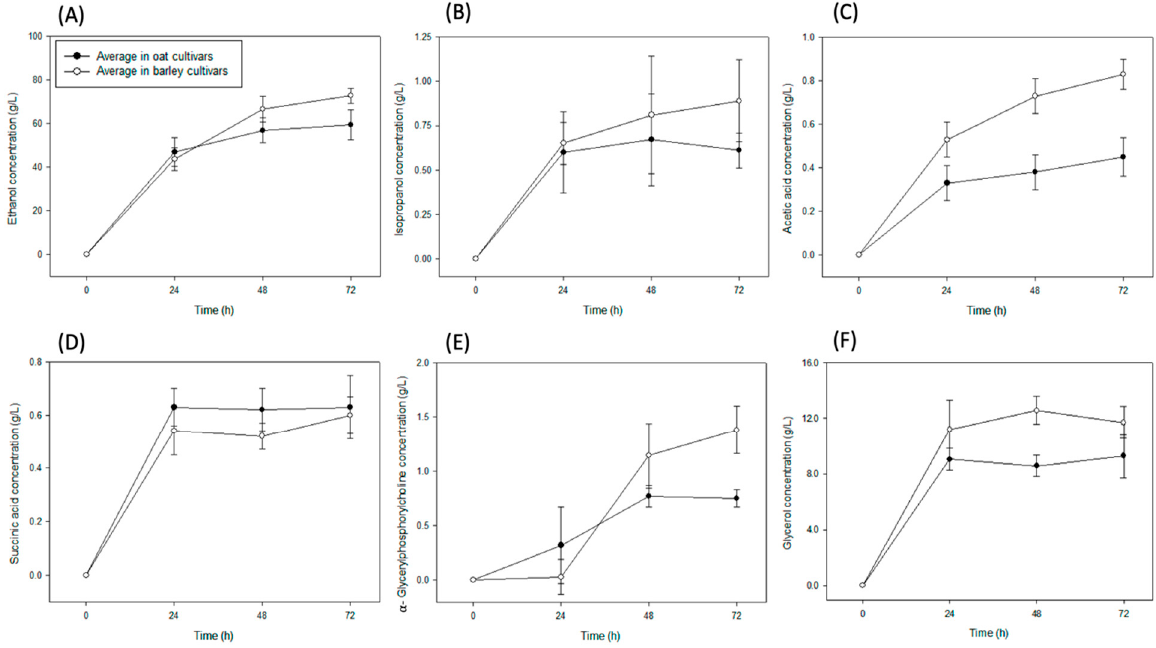
Figure 3. Average barley and oat fermentation product accumulation among cultivars over 72 h for ethanol ( A ), isopropanol ( B ), acetic acid ( C ), succinic acid ( D ), α -glycerylphosphorylcholine ( E ), and glycerol ( F ).